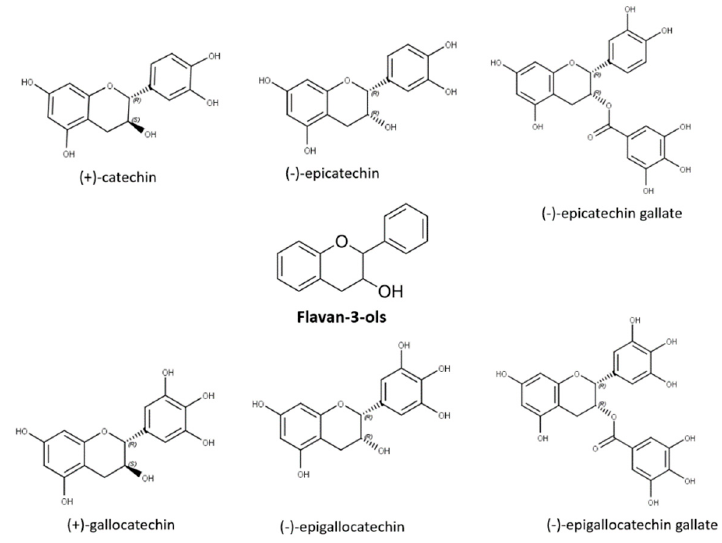
Figure 6. Flavan-3-ol monomeric forms.